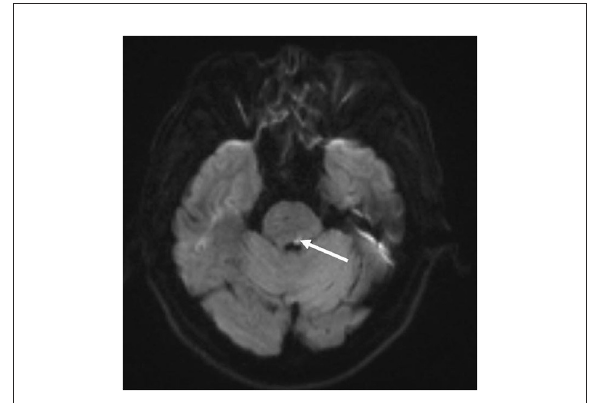
FIGURE1 Brain MRI: Diffusion-weighted images reveal a focal ischemic stroke in the dorsal pons